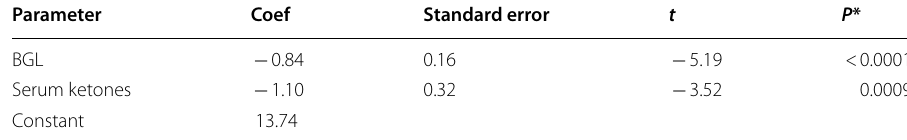
*Statistical significance ( P <